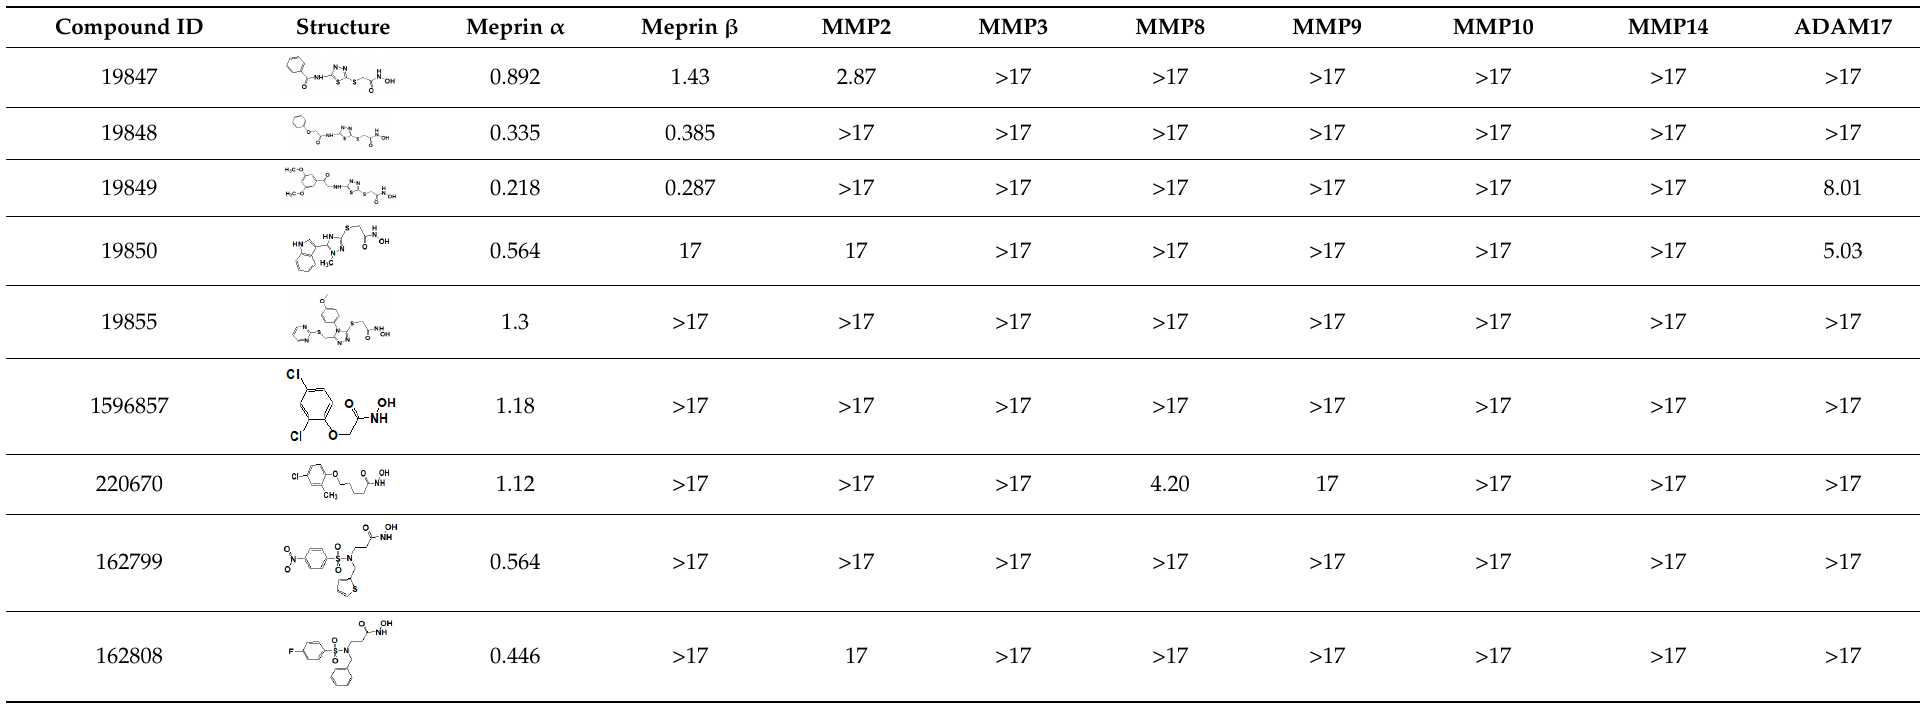
Table 2. Selectivity testing of meprin α top HTS hits. All units are IC 50 , µM.